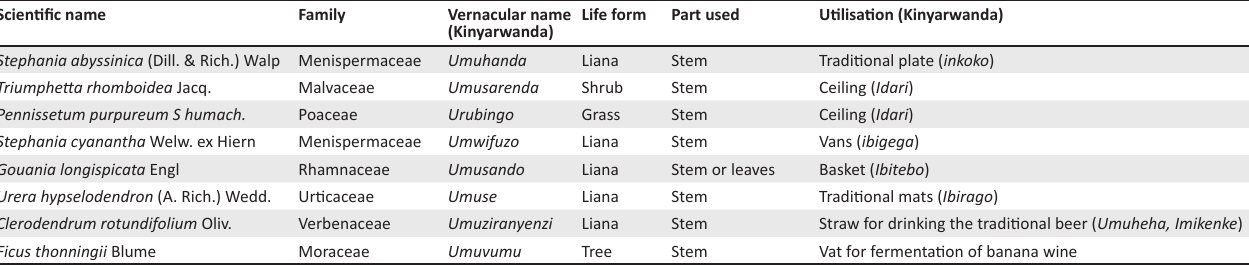
TABLE 1: Plant species uses by local communities as raw material. Scientific name